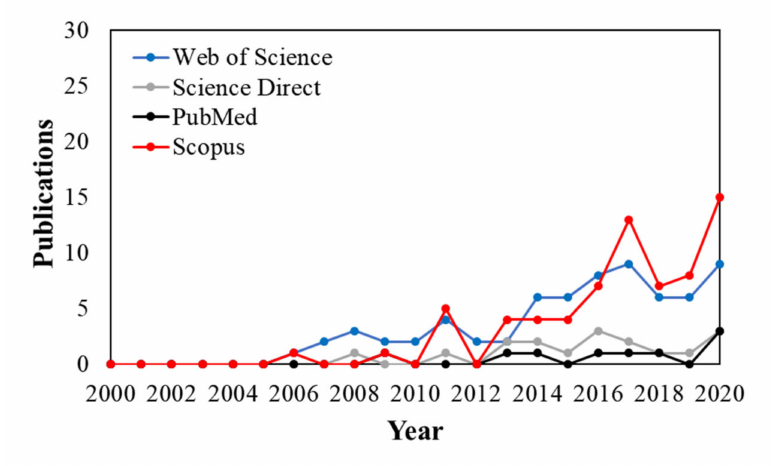
Figure 1. The publications per year according to the research database’s string search: ((“natural antimicrobials” OR “essential oils” OR “bioactive compounds”) AND (packaging OR coating OR nanopackaging) AND